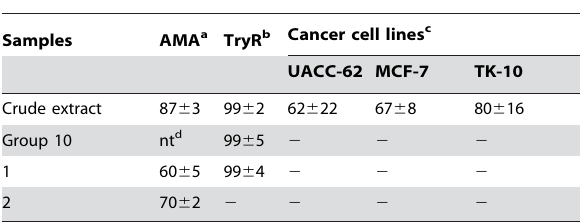
Table 1. Biological activities of crude extract, fraction, and compounds isolated from Cochliobolus sp. (UFMGCB-555) tested at a single dose of 20 m g mL 2 1